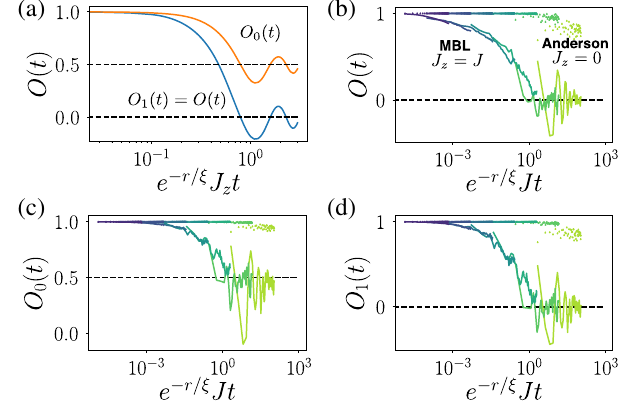
FIG. 5. MBL dynamics. (a) Values of O ð t Þ and O 0 ; 1 ð t Þ in the l -bit model. (b) – (d) Numerical simulations for a disordered XXZ chain showing that the generic scaling of O 0 ð t Þ matches O ð t Þ , while O ð t Þ ≈ O 1 ð t Þ . We use 20 random realizations of the disorder. Green to purple curves represent increasing values of j ¼ 2 ; … ; N . The lines (circles) correspond to MBL J (Anderson J z ¼ 0 ) dynamics, respectively. The x axis is rescaled using a fitted localization length ξ ¼ 2 . Other parameters: N ¼ 8 , Δ ¼ 10 J . The dashed lines represent the predictions O ð ∞ Þ ¼ 0 and O 0 ð ∞ Þ ¼ 1 = 2